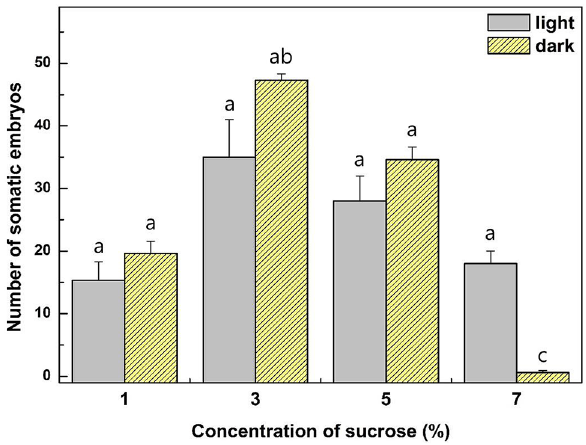
Figure 3. Effects of sucrose concentrations and light requirement on somatic embryo formation from embryogenic callus. The number of somatic embryos from different combinations of treatments of 1, 3, 5, 7% sucrose in the light or dark incubation. Each treatment consisted of 10 embryogenic calli in a Petri dish and was repeated three times. Error bars represent SE (N = 30). Different lowercase letters on the bars indicate significant differences between each treatment at the 5% level (ANOVA followed by a Turkey’s test, p < 0.05).